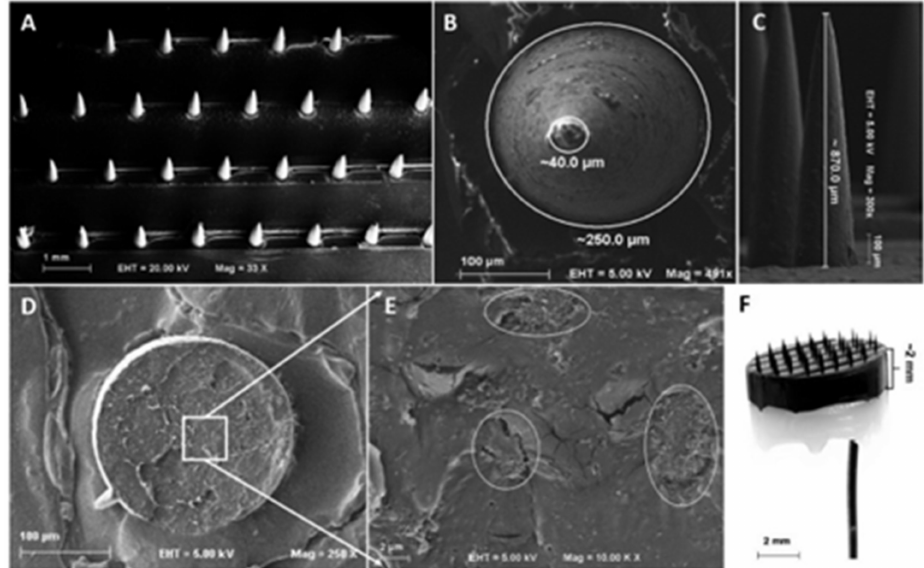
Figure 8. SEM images: ( A ) conical microneedles fabricated through a micromolding technique, ( B ) lateral dimensions of the microneedles, ( C ) longitudinal dimension of the microneedle, ( D ) mor- phology of fractured microneedle along with the stump, ( E ) enlarged fracture morphology, and ( F ) micrographic image showing the complete view of the microneedle mounted on an composite base (reprinted from Ref. no. [97], copyright 2019, American Chemical